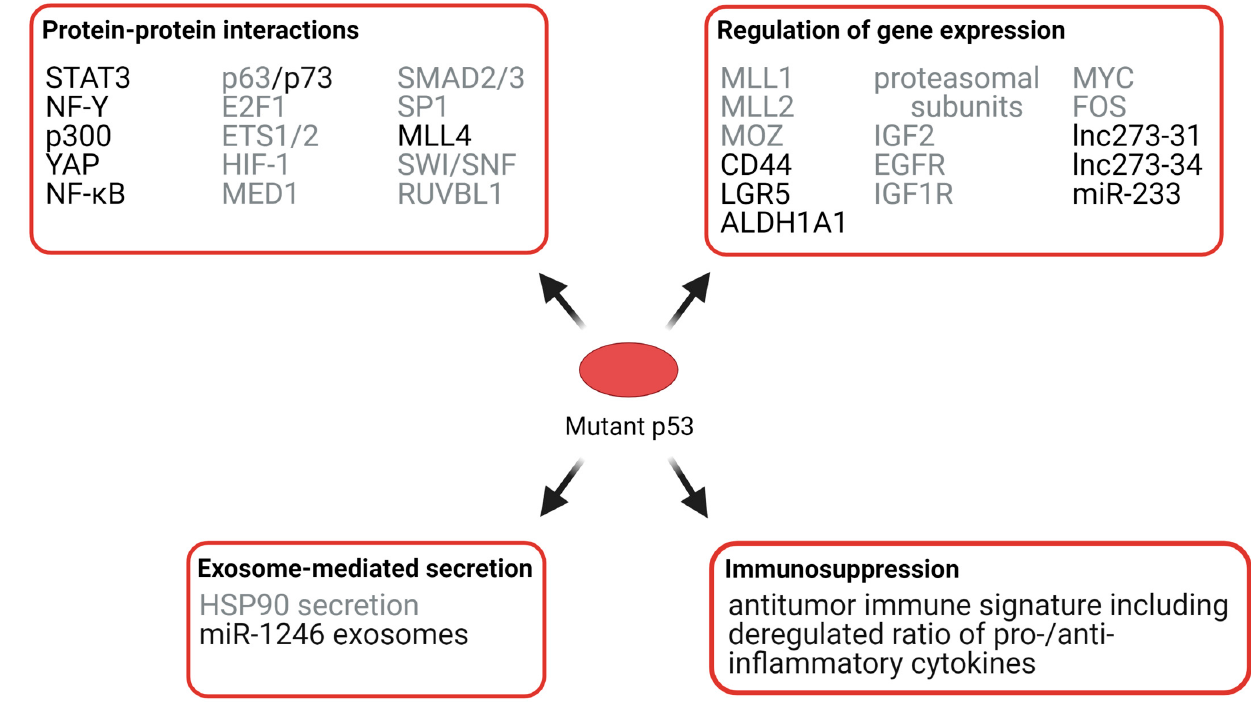
Figure 5. Selected mechanisms of p53 GOF in cancer. Mutant p53 can exert its GOF via protein–protein interactions, the regulation of gene expression, exosome-mediated secretion of biological-active molecules, and immunosuppression. Mechanisms that have been shown in CRC are labeled in black. Mechanisms that have been demonstrated in other types of cancer but might also be involved in CRC are labeled in grey.